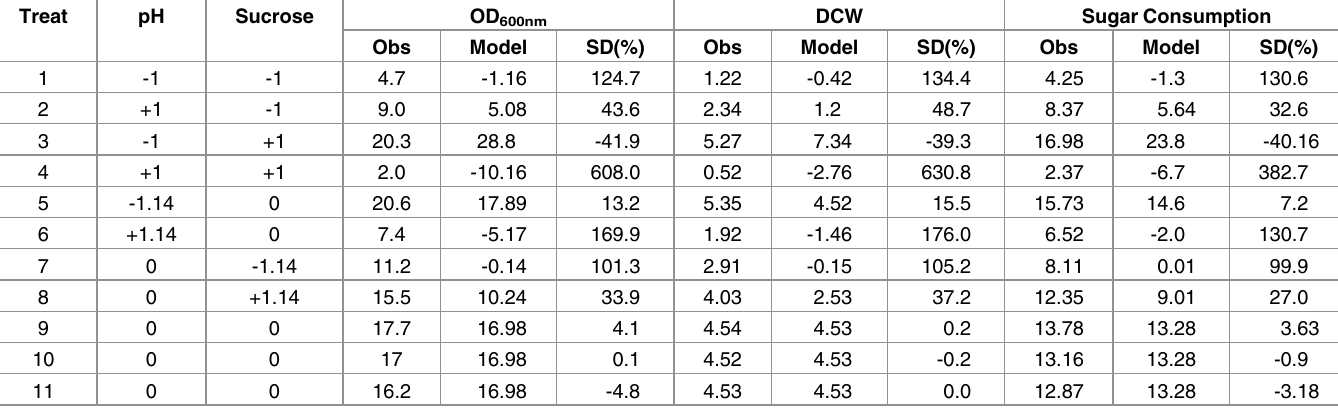
Treat, treatments; Obs, responses experimentally observed; model, results of predictive model; SD, relative standard deviation; OD 600nm , optical density; DCW, dry cell weight.